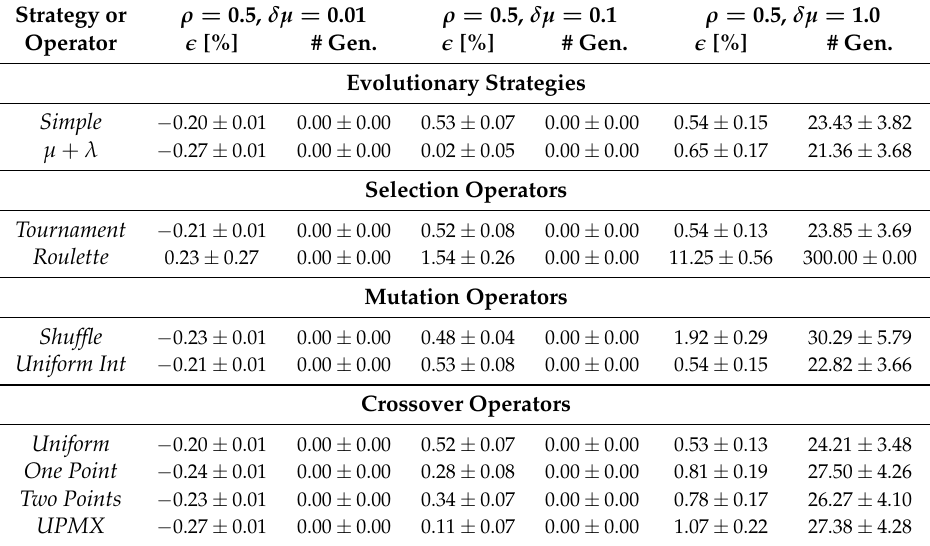
Table 3. Evolutionary